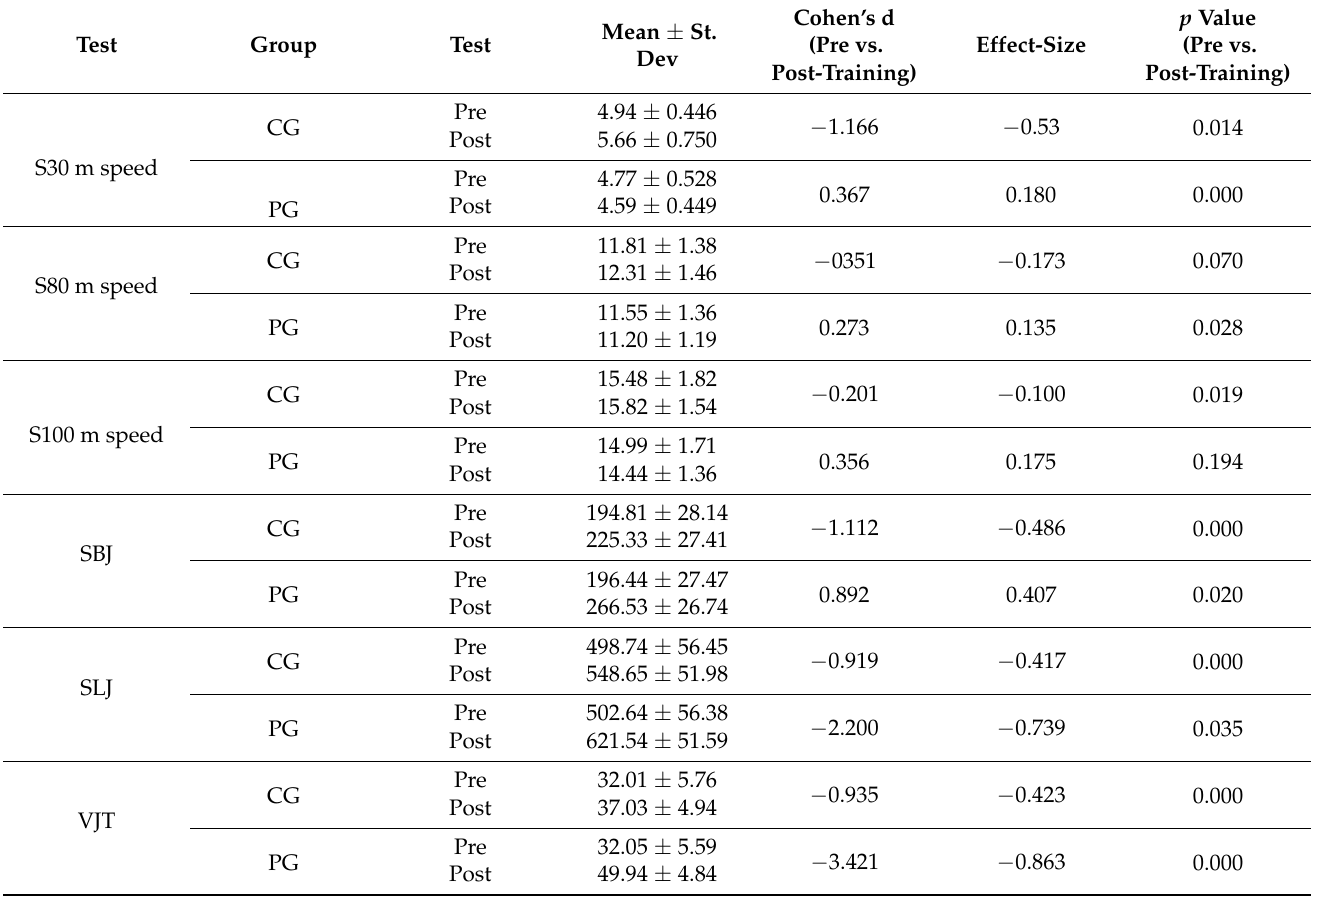
Table 3. Descriptive statistics of the tests for both groups of